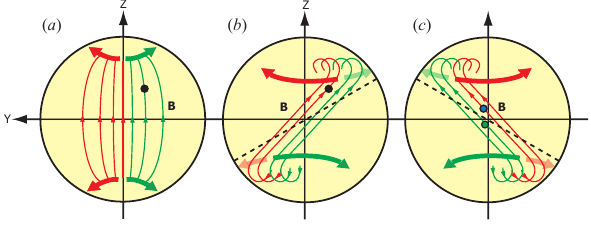
Fig. 6. Schematic view of the Earth from the tail in the GSM y-z plane, with closed plasma sheet field lines represented by the thin arrowed curves and the direction of the TRINNI flow bursts in the ionosphere being indicated by the thick arrowed curves. The field lines and flow bursts are coloured according to whether they recon- nected post- (red) or pre- (green) midnight. (a) shows the B Y ∼ 0 scenario, (b) B Y < 0 and (c) B Y > 0. The locations of Cluster 3 and 4 (from I-2) are also indicated in (c) (not to scale) by the green and blue filled circles,